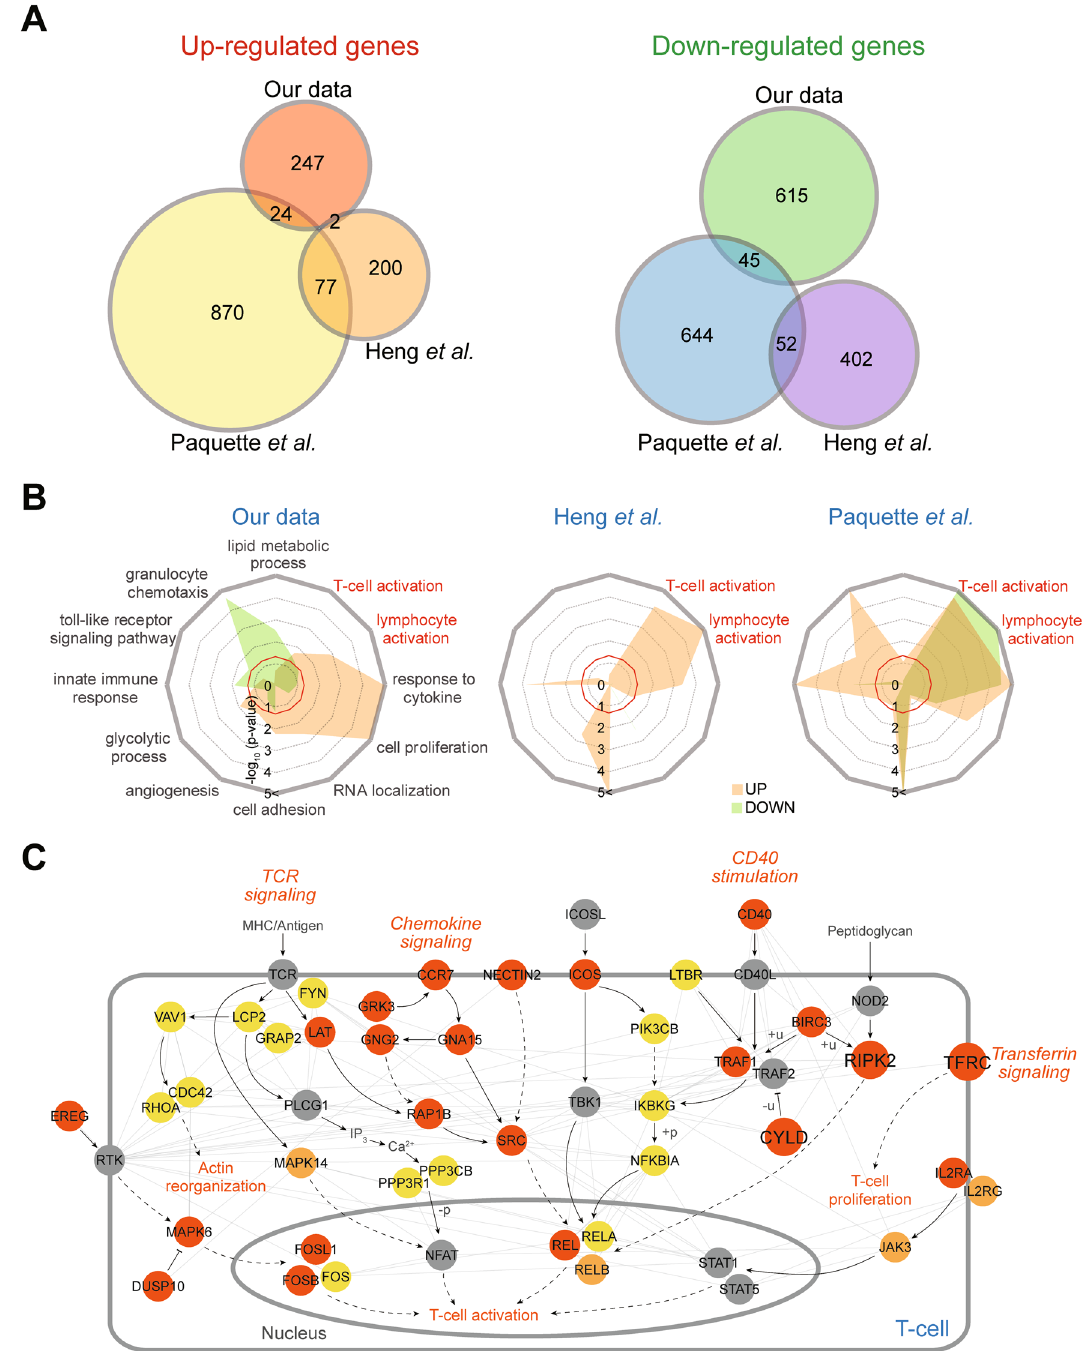
Figure 3. Core PTB-associated pathways identified by integration of the previous datasets. ( A ) Venn diagrams showing the relationships among upregulated (left) and downregulated genes (right) in PTB, compared to that in FTB, identified from our data and two previous datasets (Heng et al. 13 and Paquette et al. 14 ). ( B ) Radar charts showing the GOBPs enriched by our DEGs (left) in comparison with those enriched by the DEGs from Heng et al. (middle) and Paquette et al . datasets (right). Significance ( p value) of the GOBPs enriched by the up- or downregulated genes is displayed as − log 10 ( p value). ( C ) Network model describing interactions among the upregulated genes involved in the T-cell activation-associated processes in any of the three datasets. Dark orange, orange, and yellow nodes represent the upregulated genes identified from our data and Heng et al . and Paquette et al . datasets, respectively. See the legend of Fig. 2B,C for nodes, edges, and